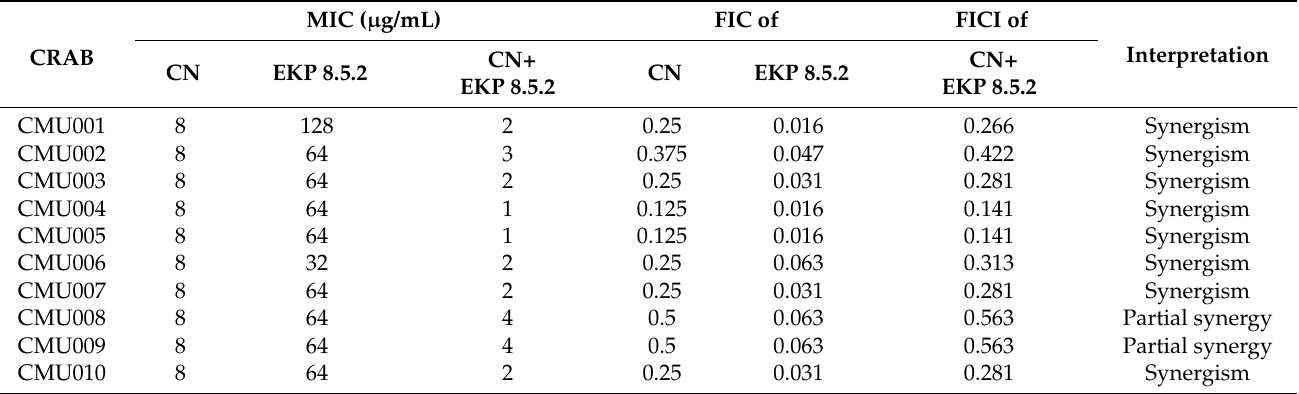
Table 8. Combination effect of gentamicin and EKP 8.5.2 extract against